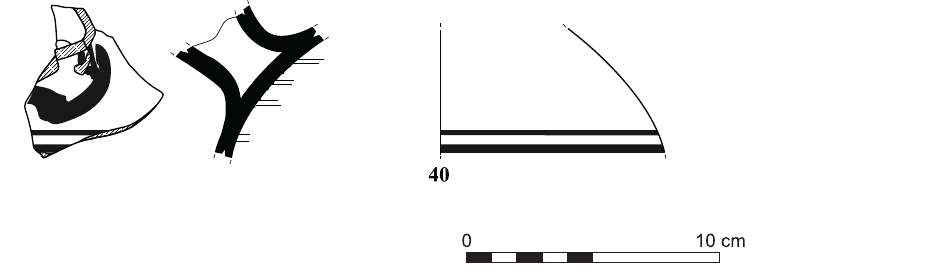
Fig 39. Body and spout fragment of a White Painted I-II strainer jug (125772).